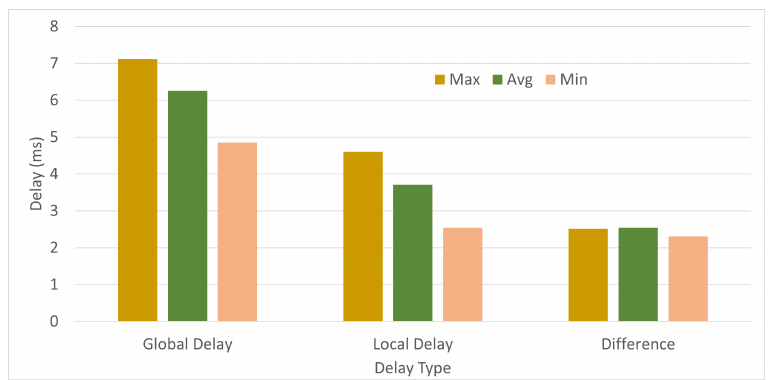
Figure 10. Descriptive statistics of global and local delays.